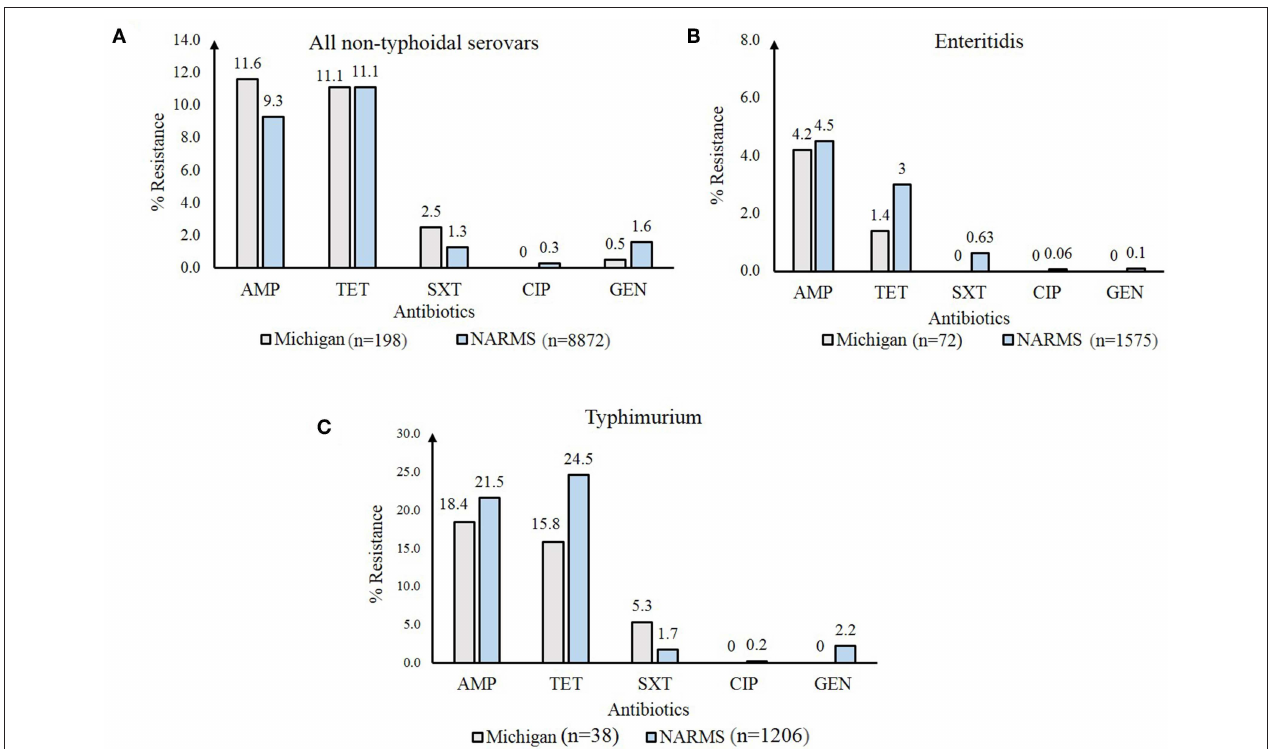
FIGURE 5 | Frequency of antibiotic resistance among Non-Typhoidal Salmonella (NTS) isolates from Michigan compared to those from the National Antimicrobial Resistance Monitoring System (NARMS) ( 29), 2011-2014. Resistance frequencies in: (A) all NTS serovars; (B) Enteritidis; and (C) Typhimurium. AMP, ampicillin; TET, tetracycline; SXT, trimethoprim-sulfamethoxazole; CIP, ciprofloxacin; GEN,